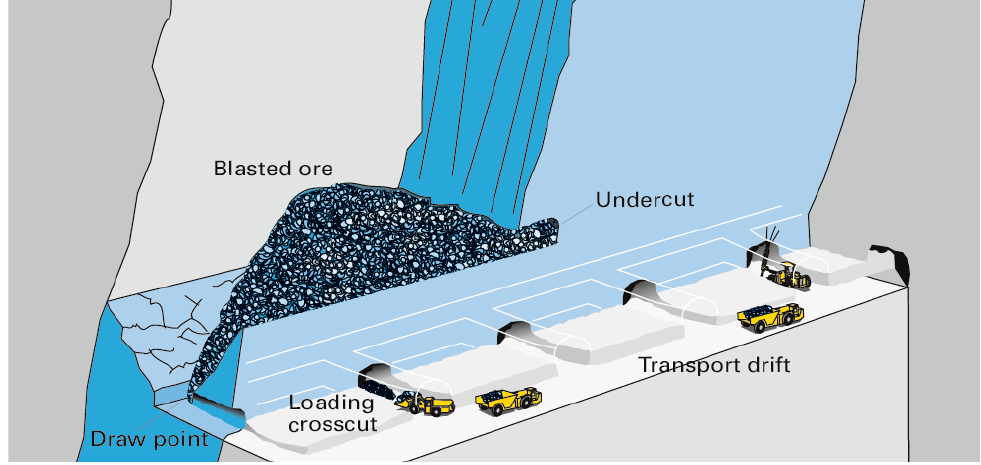
Figure 2. Example of a typical stoping layout [21]. Reprinted/adapted with permission from Ref. [21]. 2023, Epiroc Deutschland GmbH.